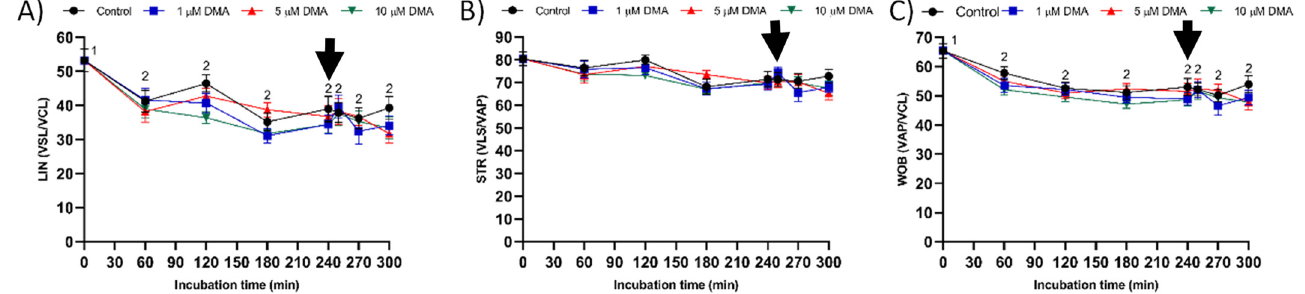
Figure 5. LIN ( A ), STR ( B ), and WOB ( C ) during in vitro capacitation in the control and samples blocked with 1, 5, and 10 µM DMA. Different numeral superscripts indicate significant differences between two consecutive time points within a treatment ( p < 0.05); since the pattern of variation of LIN and WOB was similar between control and blocked samples throughout the incubation time, all treatments have the same numeral superscript assigned to each time point. Lack of numeral superscripts indicate no significant differences in STR between treatments within a single time point ( p > 0.05). The arrow indicates the addition of 10 µg/mL of progesterone at 240 min of incubation. Results are expressed as the mean ± SEM ( n = 9).